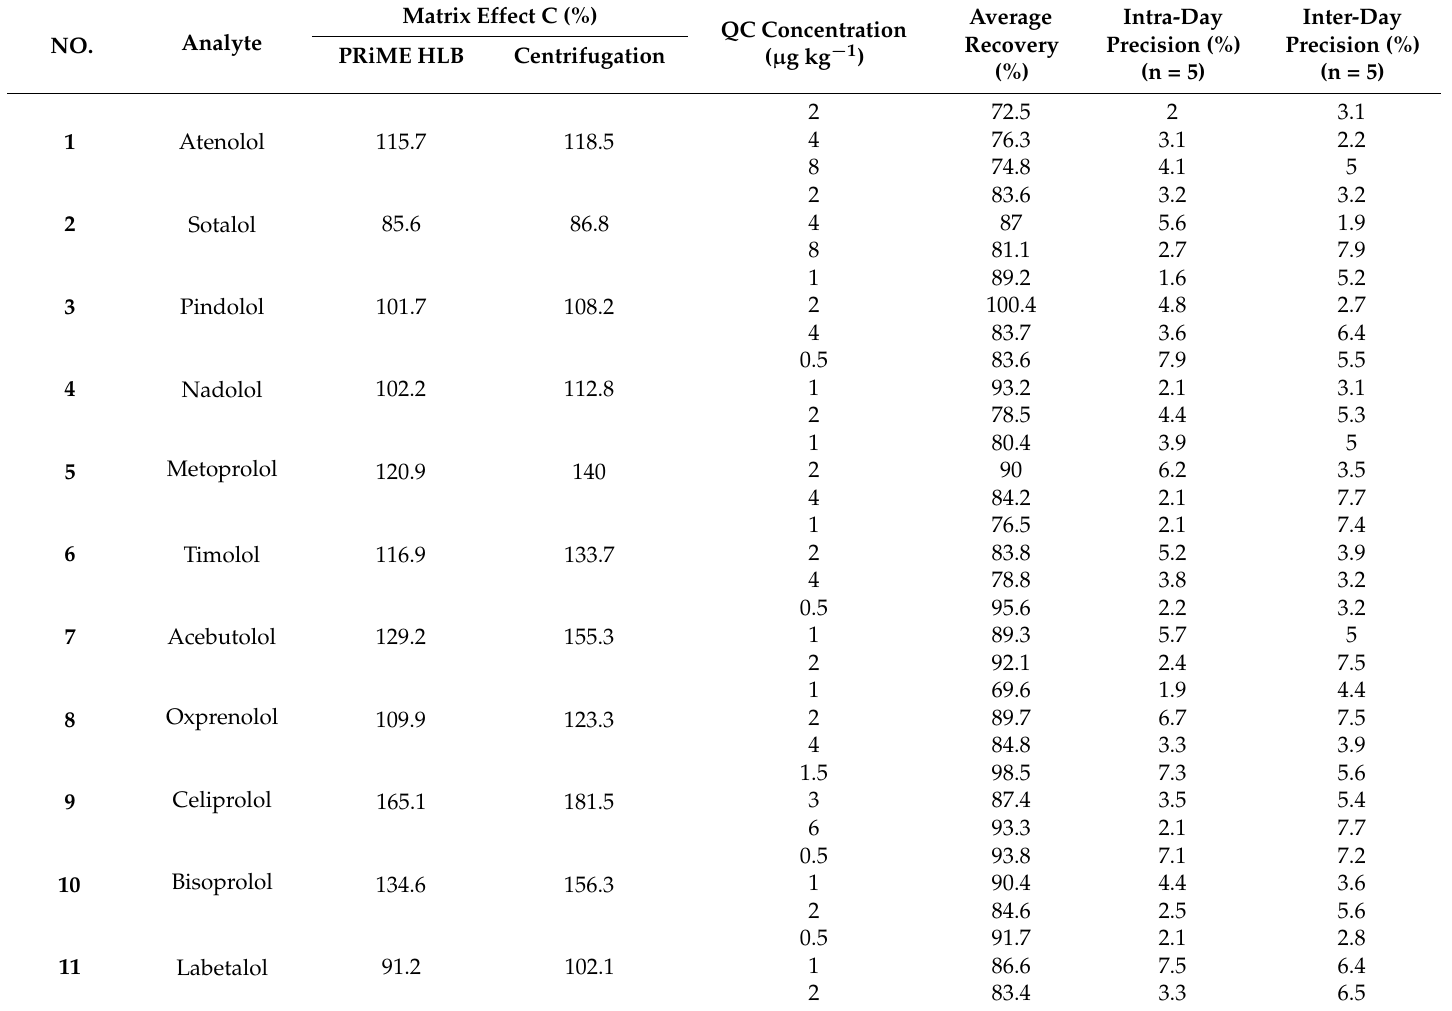
Table 3. Validation parameters of the developed